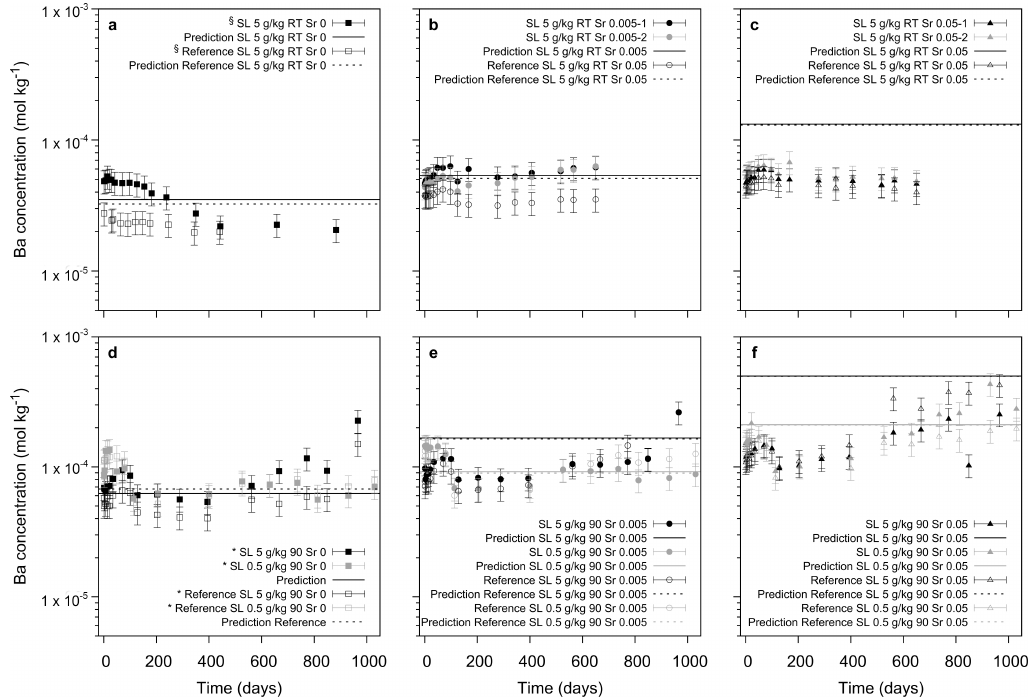
Figure 4. Temporal evolution of aqueous Ba aq concentrations at ambient conditions ( a – c ) and 90 ◦ C ( d – f ). Left column: experiments without Sr, middle column: experiments with 0.005 g/kg Sr and right column: experiments with 0.05 mol/kg Sr in the aqueous solution. The lines indicate predicted concentrations calculated by GEMS. Experimental data taken from Brandt et al., 2015 [7] marked § , experimental data from Vinograd et al., 2018b [21] marked with